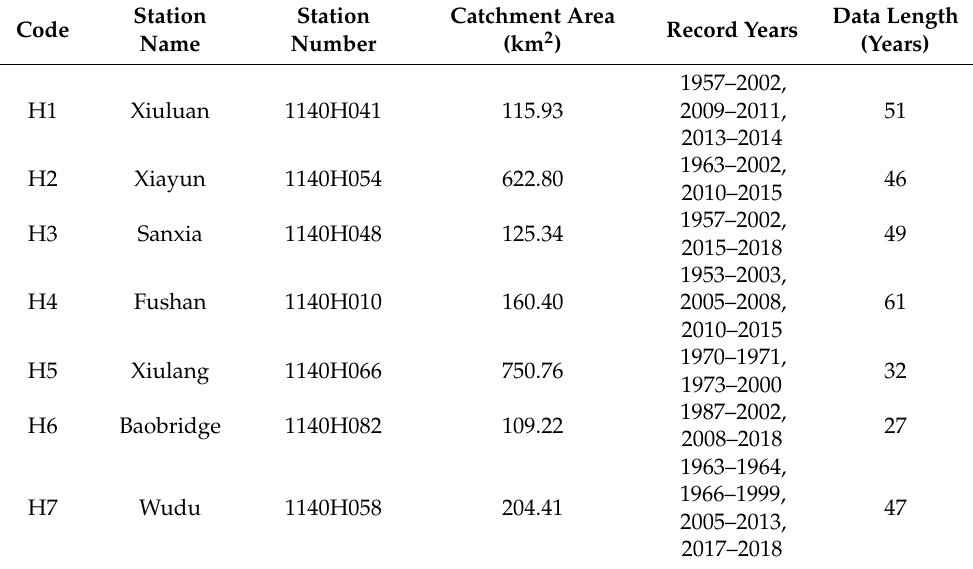
Table 3. Basic information of seven selected streamflow gauge stations in Tamsui River basin,